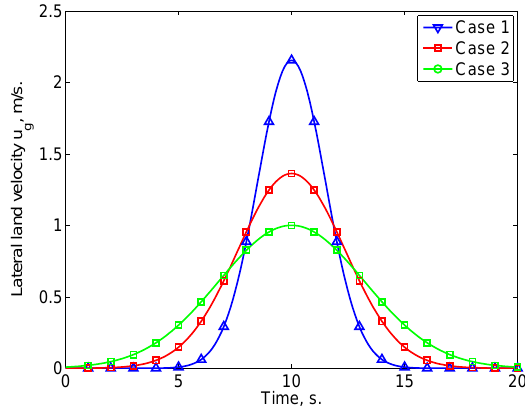
Fig. 3. Assumed lateral velocity of the land motion traverse the canal. The direction is shown in Fig. 2 by the red arrow. The total displacement for all cases is